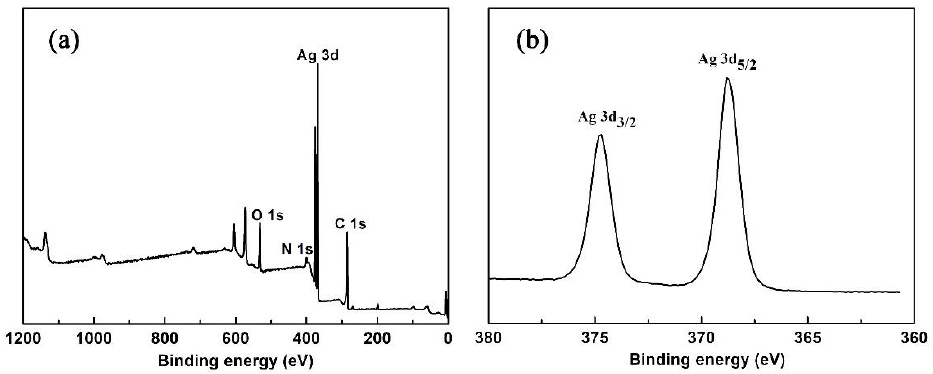
Figure 3. ( a ) XPS survey spectrum of 1 ; ( b ) XPS spectrum of 1 for Ag 3d 3/2 and Ag 3d 5/2 .